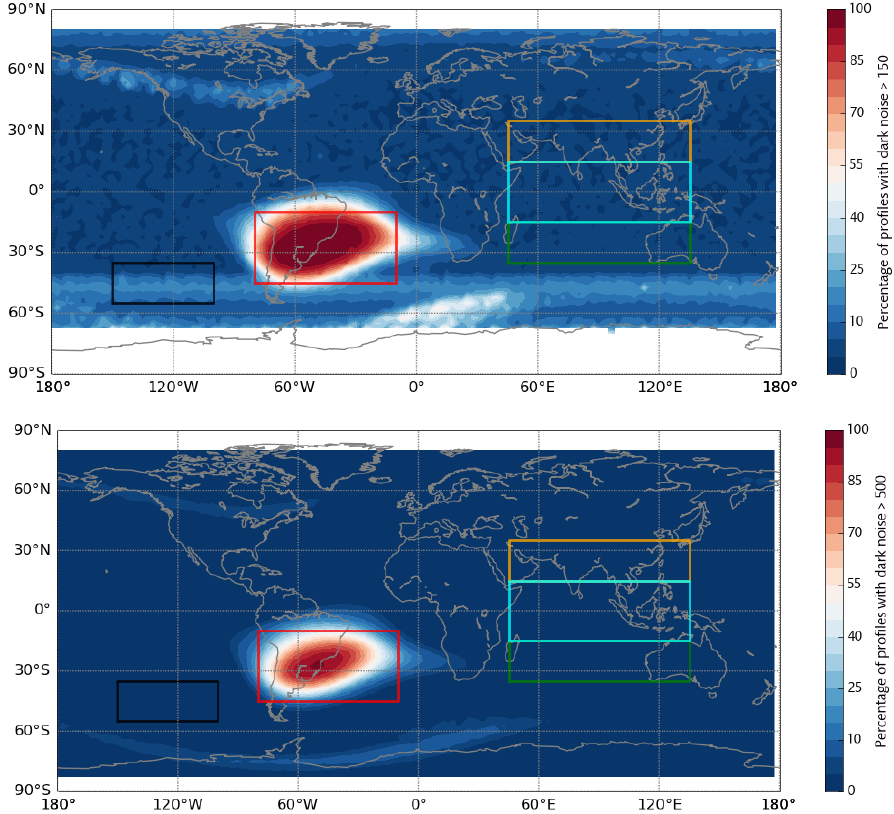
Figure 1. Percentage of profiles at 333m horizontal resolution with dark noise above 500 in 2.5 ◦ × 2.5 ◦ bins for all 2007 CALIOP nighttime Fig. 1: (top) Percentage of profiles at 333m horizontal resolution with dark noise above 150 observations. The red box delimits a region affected by the SAA, enclosing all bins with more than 50% noisy profiles (top left: 80 ◦ W, 10 ◦ S, in 2.5° x 2.5° bins in January 2007 CALIOP nighttime observations. (bottom) Same as top, bottom right: 10 ◦ W, 45 ◦ S), The three boxes between 45 ◦ E and 135 ◦ E delimit regions unaffected by any recognized source of increased for profiles with dark noise above 500 in 2007. The red box delimits a region affected by noise levels, in the Southern Hemisphere (35 ◦ S to 15 ◦ S, green), the Northern Hemisphere (15 ◦ N to 35 ◦ N, orange) and around the Equator the SAA, enclosing all bins with more than 50% noisy profiles (top left: 80°W 10°S, bottom (15 ◦ S to 15 ◦ N, right: 10°W 45°S), The three boxes between 45°E and 135°E delimit regions unaffected by any recognized source of increased noise levels, in the South hemisphere (35°S to 15°S, green), the North hemisphere (15°N to 35°N, orange) and around the equator (15°S to 15°N, cyan). The black box delimits a region strongly affected by sunlight scattering in January, but not by the SAA or the polar auroras (top left: 150°W 35°S, bottom right: 100°W, 55°S). ! !